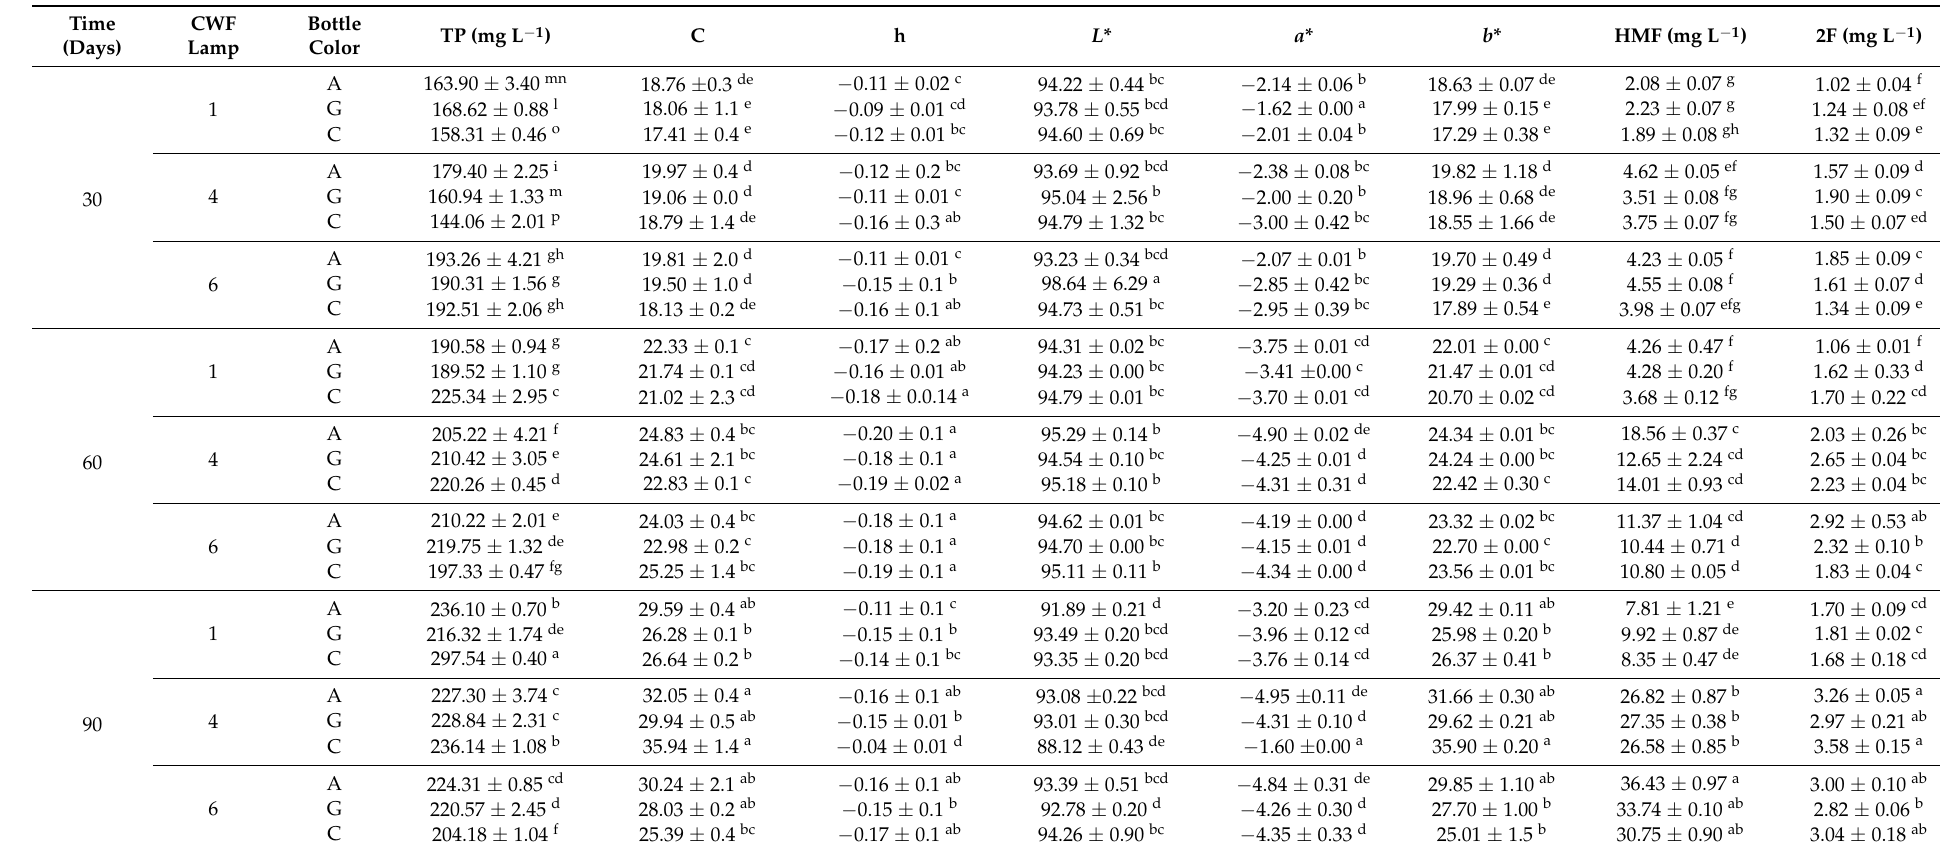
Table 3. Quality parameters of MdL wine samples as influenced by light exposure (number of CWF lamps) and clear-colored glass bottles (A = amber; G = green; C = colorless)